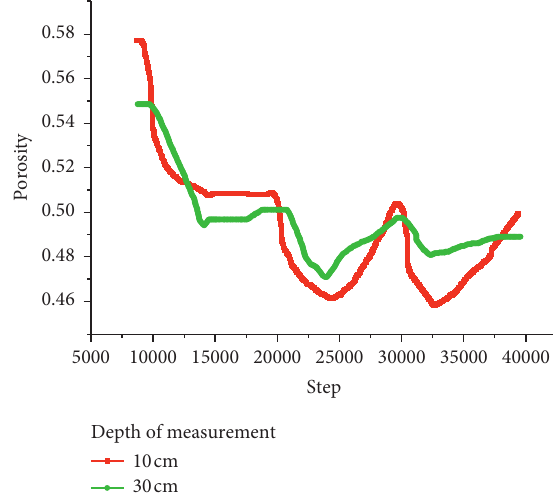
Figure 25: Curve of porosity change of 70cm thick reclaimed soil with three